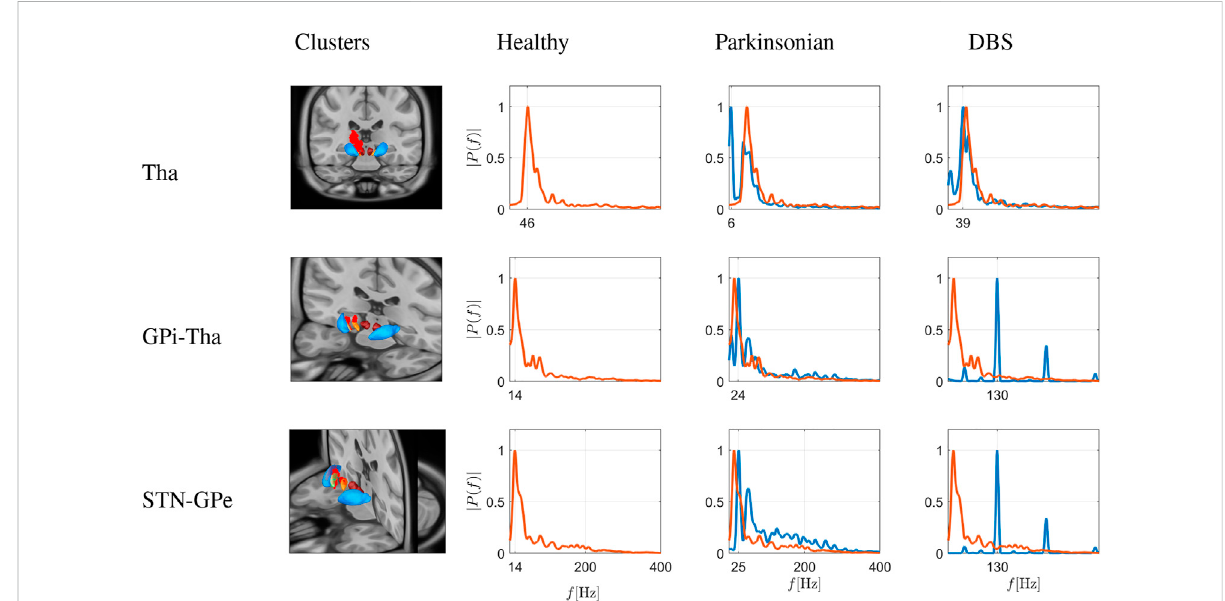
FIGURE 9 Simulation of frequency spectrograms of basal ganglia and thalamic sets of nodes as average neuronal activity (power on ordinate given as relative value) in a frequency range of 0 – 400 Hz. The three rows depict node sets emerging from modularity analysis in the thalamus (top), in the GPi-thalamicpathway(middle)andtheSTN-GPepathway(bottom),depictedasreddotsonthevirtualbrainsections.Thespectrogramscorrespond to healthy conditions (red traces), Parkinsonian conditions and DBS in a Parkinson-affected network (both as blue traces), as shown in the differentcolumns.Tracesfromhealthyconditionsaresuperimposedas fi nered traces.Underhealthyconditions, theactivitypeaksinthelow γ band (i.e., ≈ 46 Hz) in the thalamus, while in the pathways projecting from GPi to the thalamus and projecting from the STN to GPe, low frequency activity in the low β band is seen (i.e. ≈ 13 – 14 Hz). Under Parkinsonian conditions, the situation reverses: in the thalamus, higher frequency γ activity is blunted, and low-frequency activity emerges (at ≈ 6 Hz, i.e., θ band), while in the cited pathways, peak frequencies are shifted to higher frequencies ( ≈ 25 and 50 Hz, i.e., in the β and low γ band). DBS clearly changes this situation: In the pathways directly connected to the STN (which is the stimulation target), the dominant frequencies are in the DBS frequency and harmonics (i.e., 130 and 260 Hz). This leads to a restoration of thalamic activity, where again the activity is peaking in the low γ band (i.e., ≈ 38